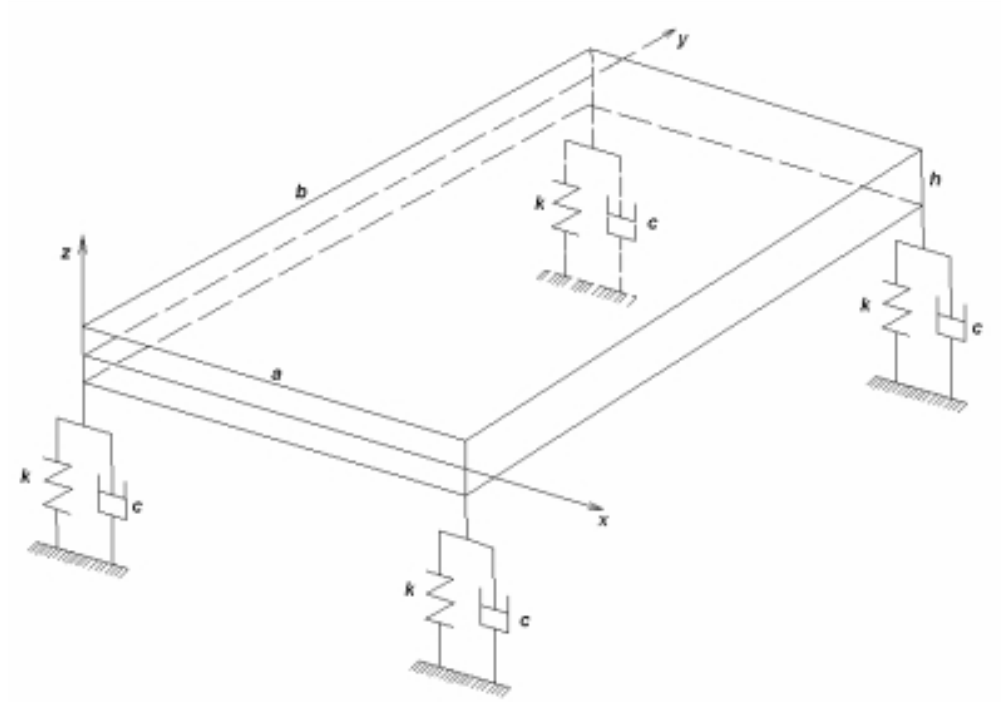
Fig. 1. Rectangular plate with Kelvin type boundary conditions at four